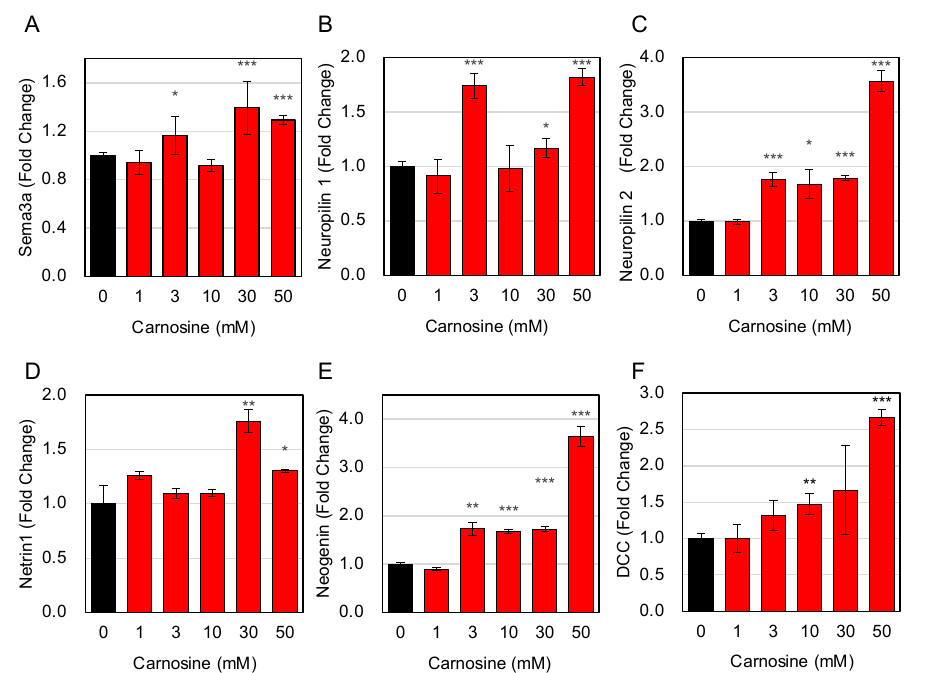
Figure 3. Effects of carnosine on the expression of slow and fast-related factors in myotube cells. C2C12 cells were differentiated in the presence of indicated amount of carnosine. Expression of slow and fast muscle-related factor genes of Sema3a ( A ), Neuropilin 1 ( B ), Neuropilin 2 ( C ), Netrin 1 ( D ), Neogenin ( E ), and DCC ( F ) was quantitatively determined by RT-qPCR. Multiple comparisons between groups were performed using one-way ANOVA with Tukey’s post-hoc test. Statistical significance was defined as p < 0.05 when compared to control (* p < 0.05; ** p < 0.01; *** p < 0.001).